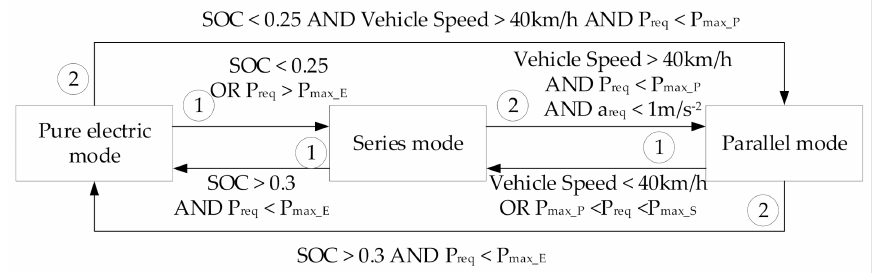
Figure 11. Mode selection strategy based on logic